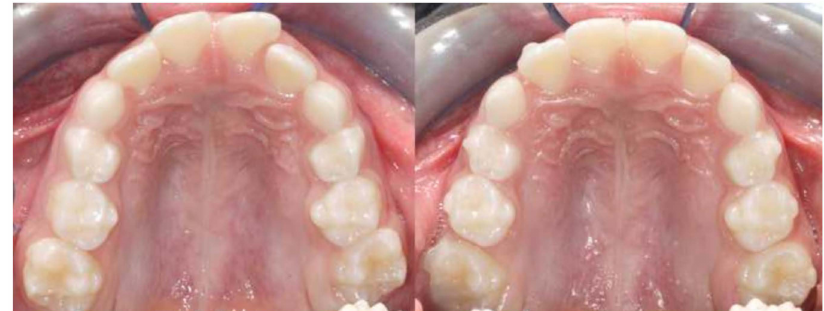
Figure 3. Intraoral occlusal evaluation pre-treatment (T1) and post-treatment